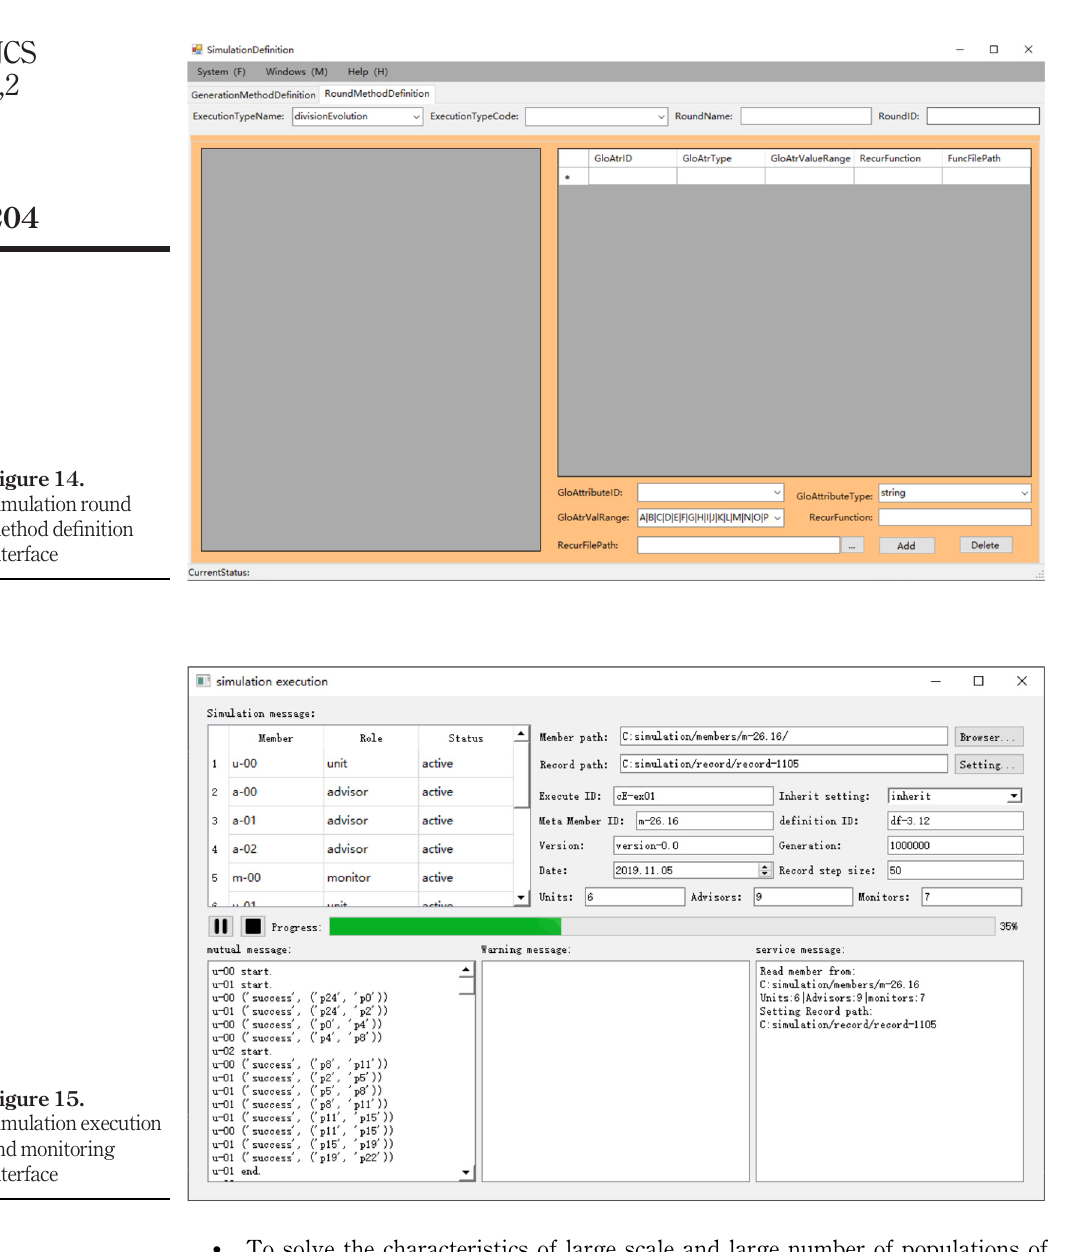
Figure 15. Simulation execution and monitoring